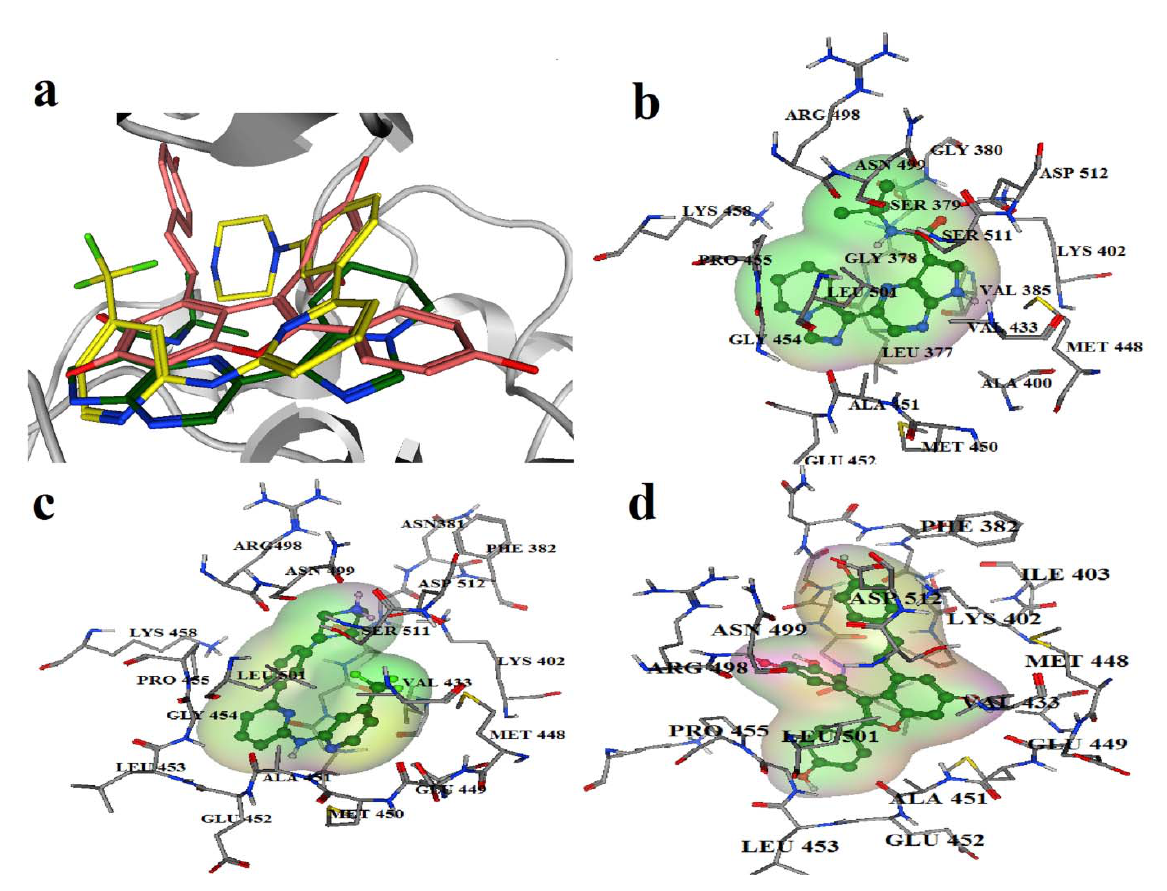
Figure 4. ( a ) Docked structures of 1B6 (green), OSB (yellow) and Vam3 (pink) with Syk; ( b ) The binding site positioned around 1B6; ( c ) The binding site positioned around OSB; ( d ) The binding site positioned around